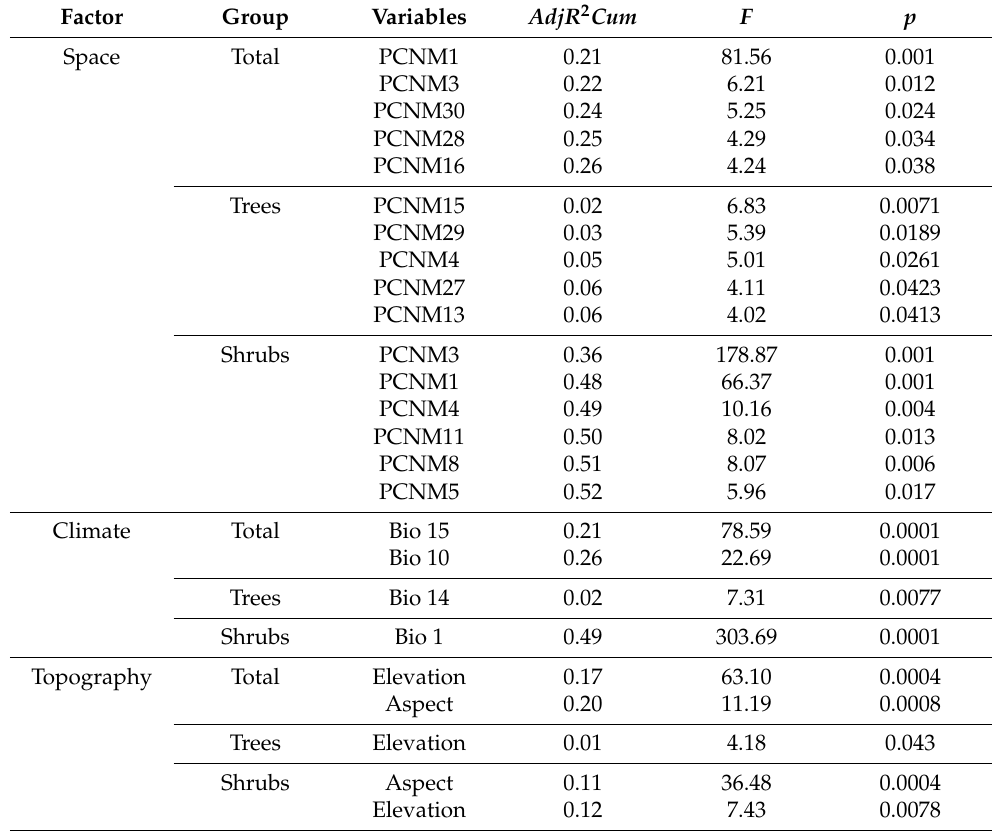
Table 2. Spatial, climatic, and topographic variables, which were selected by the forward selection procedure in the RDA, affected net relatedness index (NRI) of communities for total, trees, and shrubs at three different communities. PCNMs(principal coordinates of neighbor matrices) represents spatial predictors; Bio1(annual mean temperature), Bio10(mean temperature of warmest quarter), Bio14(Precipitation of Driest Month), Bio15(precipitation seasonality); topographic factors include elevation, aspect, slope, and